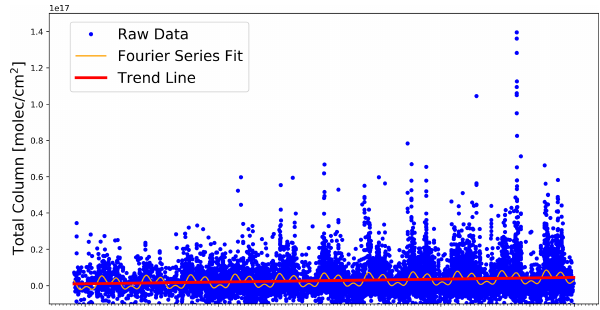
Figure 6. Time series of IASI NH 3 total columns measured within 50km of TAO. The third-order Fourier series fit and the trend line are shown in orange and red,